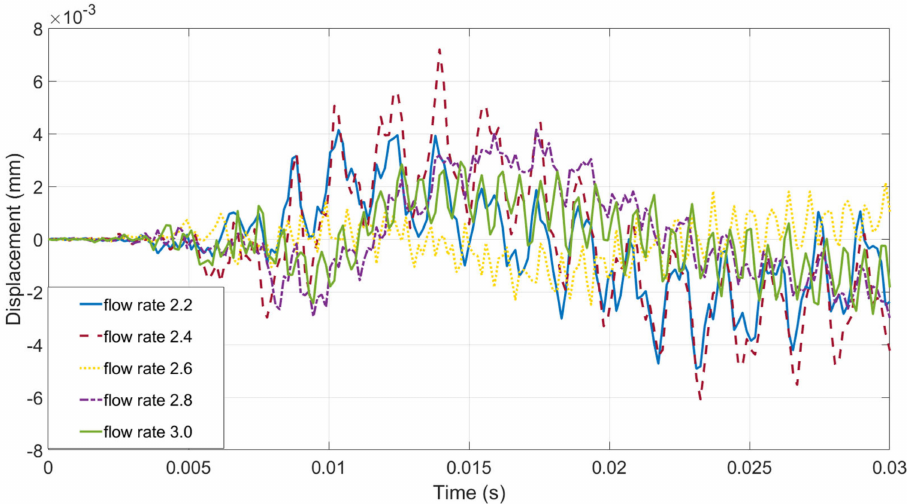
Figure 9. Relative displacement changing graph of sensor characteristic point under impacts of different momentum jets in the Y